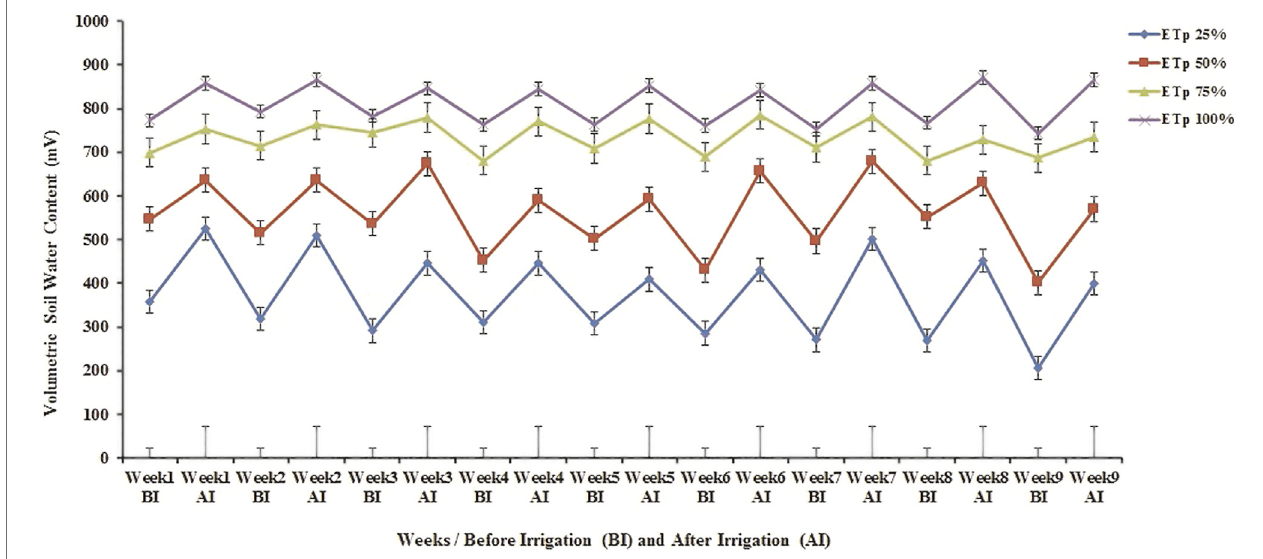
FIGURE2| Effectsofvariousirrigationregimesonvolumetricsoilwatercontent(mV)measuredbyamoisturemeterprobeinalltreatmentsduringa9-weekperiod. Bars ( ┬ ) represent the Least Signi fi cant Difference values (LSD) for comparisons between treatments at p < 0.001 and p < 0.05. d. f. = 89.